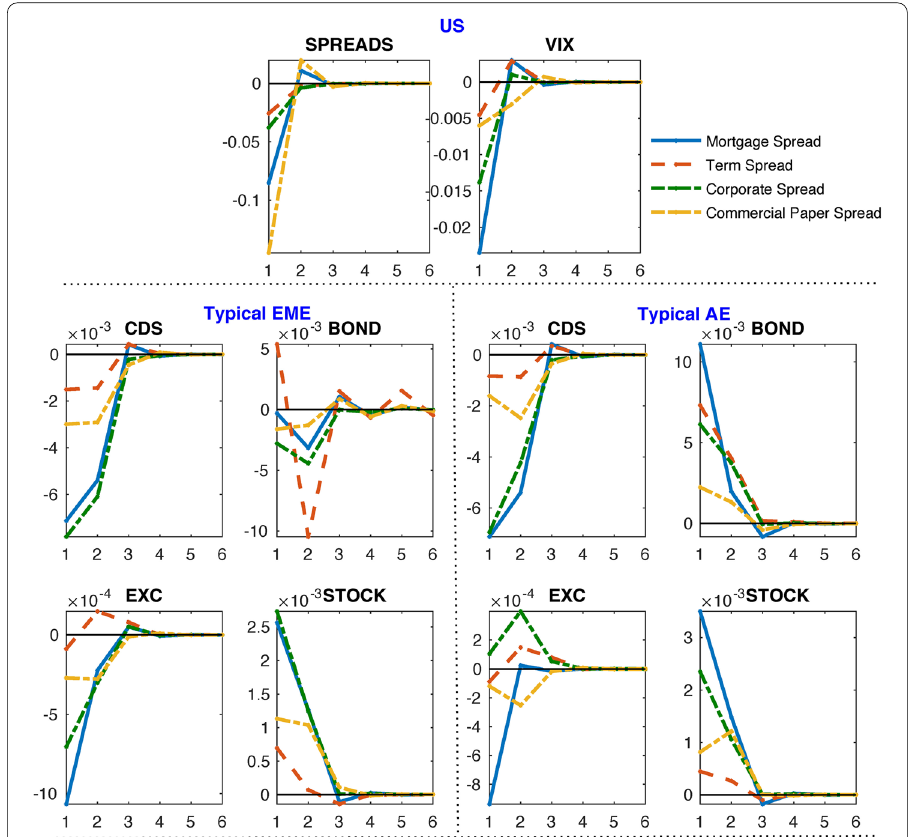
Fig. 12 Responses of typical EME and AE to US spread shocks. Notes: The country-level impulse responses to US spread shocks are available from the authors upon